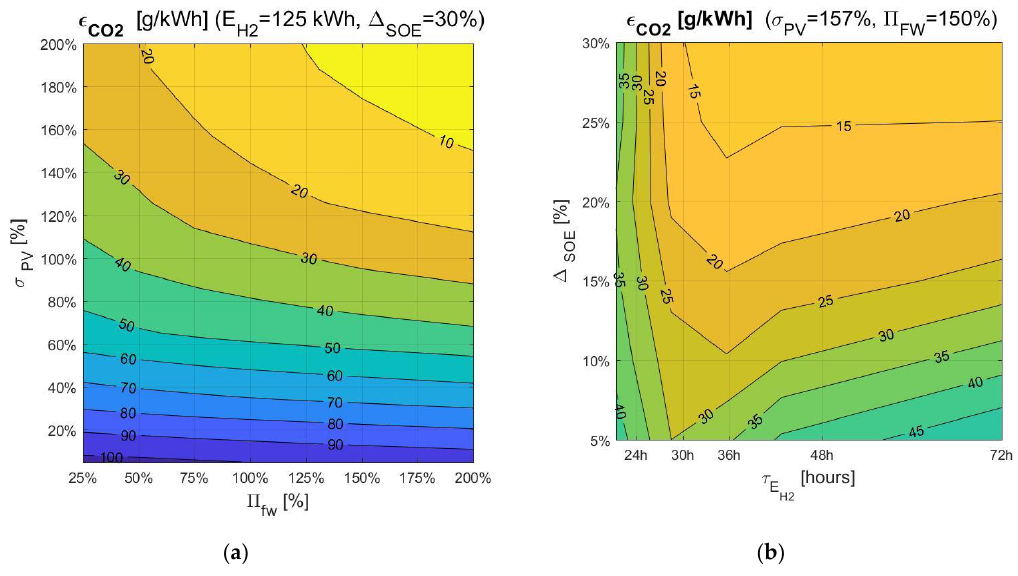
Figure 9. Sensitivity analysis of the key performance indicator ε CO 2 scored in the best mini-grid configuration reaching environmental optimization. ε CO 2 contour maps are plotted vs: ( a ) σ PV and Π FW , for constant value of 𝜏 𝐸 and Δ SOE ; ( b ) versus 𝜏 𝐸 and Δ SOE, for constant value of σ PV and Π FW.